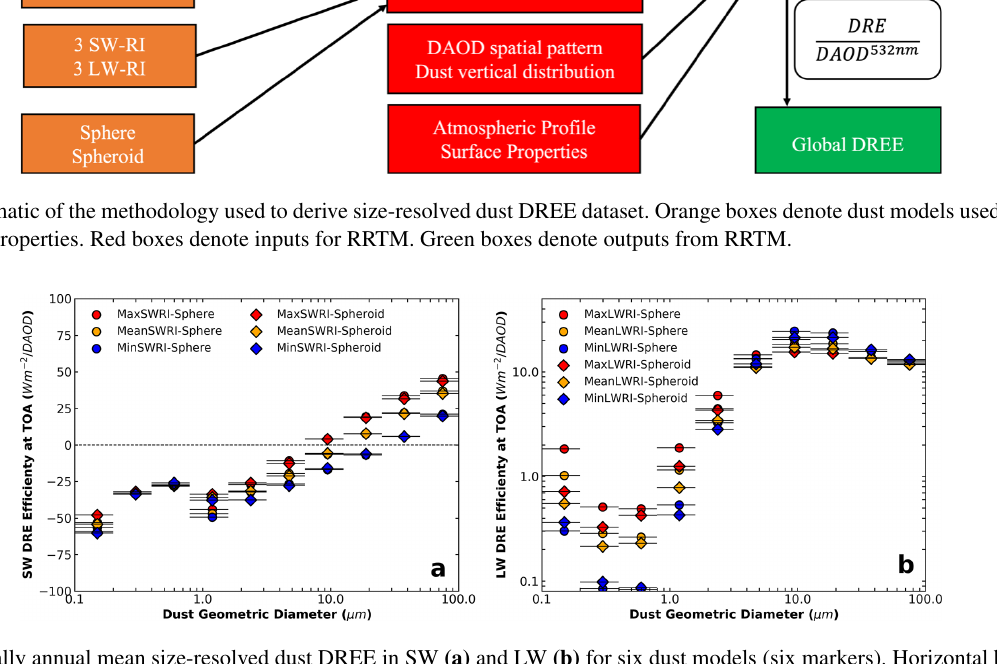
Figure 5. Globally annual mean size-resolved dust DREE in SW (a) and LW (b) for six dust models (six markers). Horizontal bars indicate the dust diameter range of each size bin. Note: LW DREE is on a logarithm scale; in contrast to global model simulations, we consider dust LW scattering in LW DRE efficiency